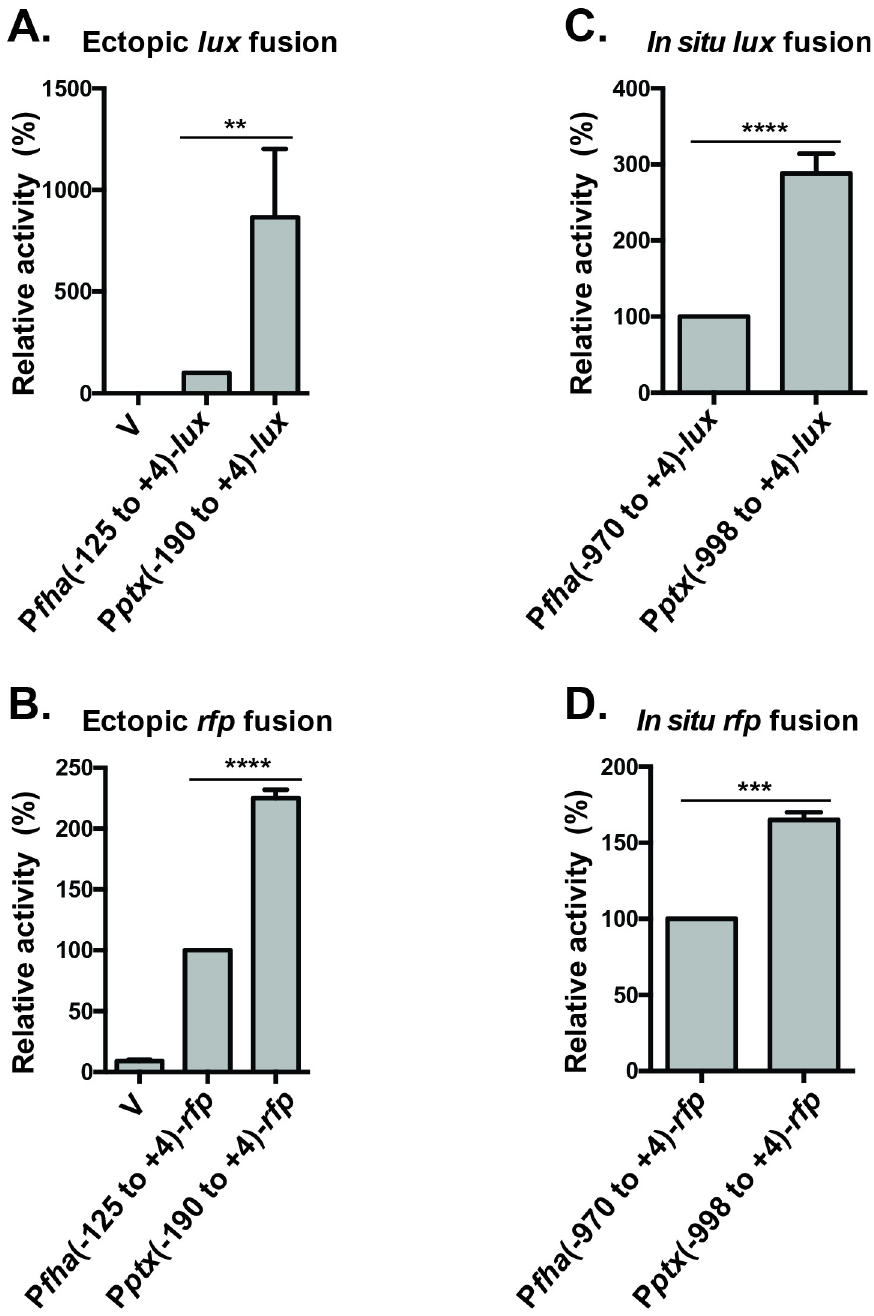
Fig 7. Comparing the relative strengths of P fha and P ptx by transcriptional fusion. Promoter- lux ( A & C ) and promoter- rfp ( B & D ) transcriptional fusions were constructed and integrated into the BP536 chromosome. Fusions to the lux operon used either pSS3967, to integrate at an ectopic location ( A ), or pSS4162, to integrate in situ ( C ). Similarly, transcriptional fusions to rfp used either pQC2241 for ectopic insertion ( B ) or pQC2319 for in situ insertion ( D ). For the two ectopic constructs “V” indicates insertion of the vector alone. This control is not possible for the in situ insertions. The extent of the promoter sequences cloned in each construct are provided as nucleotide coordinates relative to the transcriptional start. B . pertussis strains carrying these constructs were grown on BG agar at 37˚C for 2 days and analyzed for and luciferase and RFP activity as described in Materials and Methods. In each panel activity is reported relative to the P fha -promoter fusion and the results of at least four assays were used in the calculation of standard deviations and statistical analysis by an unpaired two-tailed t test between two samples. Statistical symbols are: �� , P � 0.01; ��� , P � 0.001; ���� , P � 0.0001.